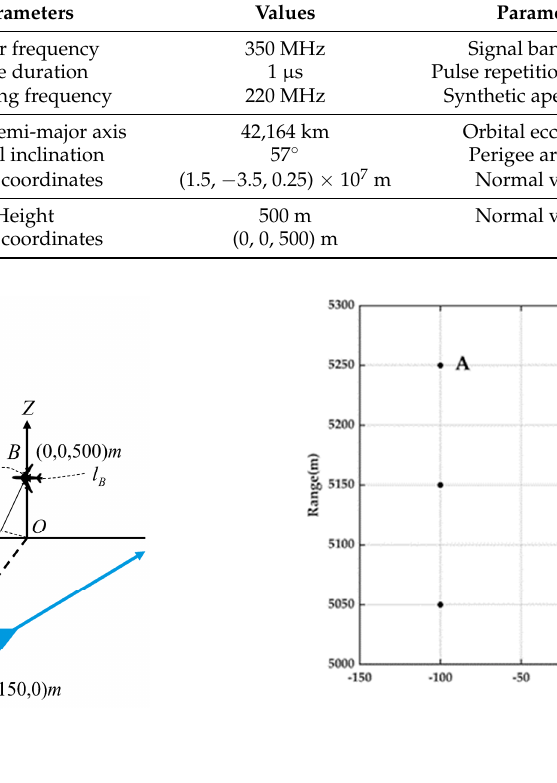
Figure 9. The experimental scene for the GEO-UAV UWB BiSAR imaging. ( a ) The imaging geometry; ( b ) The distribution of the point